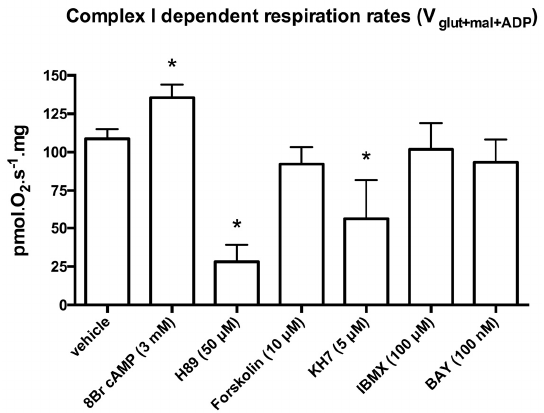
Figure 2. Mitochondrial complex I dependent “state 3” (V glut+mal+ADP ) respiration rates (pmol·O 2 ·s − 1 ·mg) of permeabilized cardiac fibers in control (vehicle) and after incubation for 30 min with 8Br cAMP; H89; KH7; 3,7-dihydro-1-methyl-3-(2-methylpropyl)-1 H -purine-2,6-dione (IBMX); or BAY 60-7550 are displayed. See Materials and Methods for details. Data are mean ± standard deviation (SD). Results were analyzed with one-way ANOVA and Bonferroni’s multiple comparison post hoc adjustment ( n = 8 in each group; * indicates adjusted p < 0.007 versus vehicle).